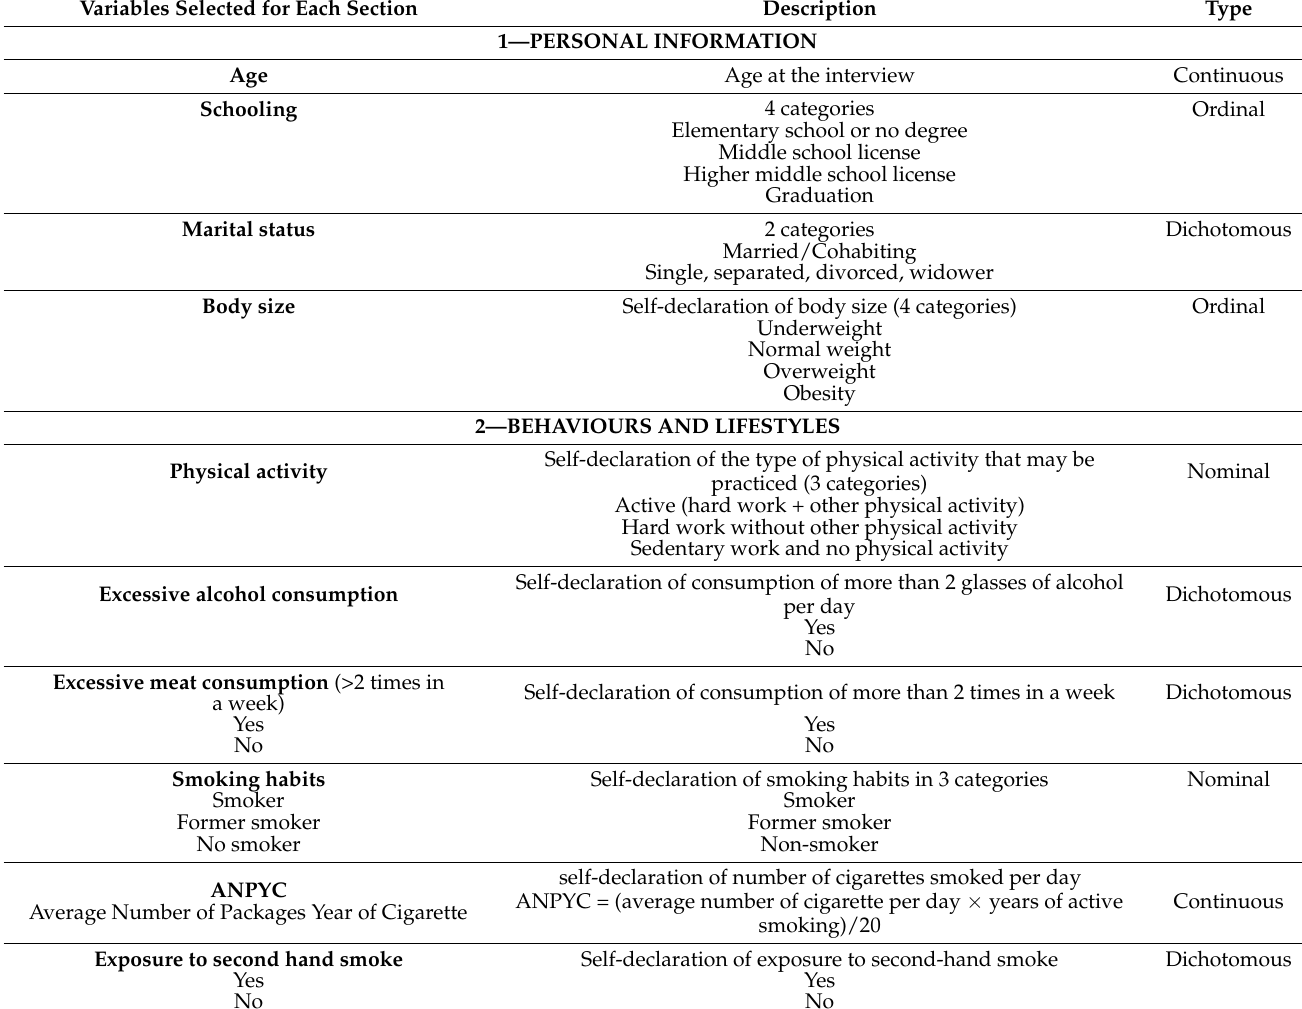
Table 1. Variables selected for the statistical